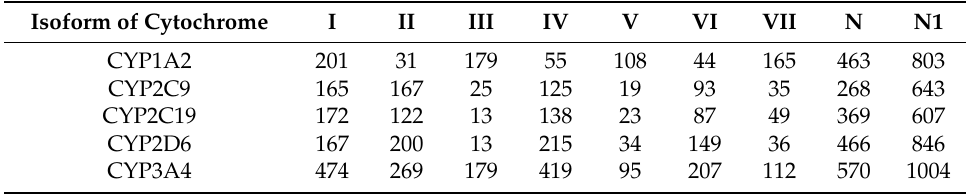
Table 4. The number of chemical structures in the modeling sets used in the